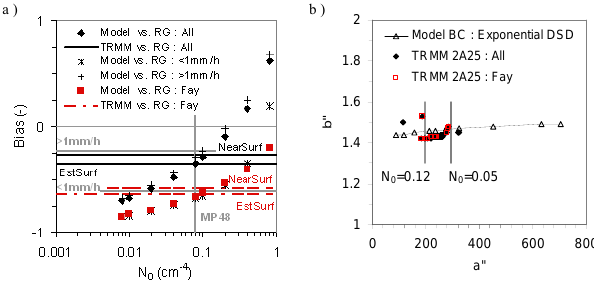
Fig. 9: Model/TRMM/RG comparison: a) Bias between modeled and 10-min rain gauge rain Fig. 9. Model/TRMM/RG comparison: (a) Bias between modeled intensity as a function of N 0 for the period 06/01/08-05/15/09 and for tropical storm Fay on and 10-min rain gauge rain intensity as a function of N 0 for the period 06/01/08–05/15/09 and for tropical storm Fay on 08/26/08. 08/26/08. For the period 06/01/08-05/15/09, TRMM near surface rain-rates are divided into For the period 06/01/08–05/15/09, TRMM near surface rain-rates subcategories (RR>1mm/h and RR<1mm/h). b) Coefficients (a”, b”) of the Z-R relationships are divided into subcategories (RR > 1mm/h and RR < 1mm/h). (b) retrieved from TRMM 2A25 (at point D: see Iguchi et al. 2000 for definition) for the period Coefficients ( a 00 ,b 00 ) of the Z-R relationships retrieved from TRMM 06/01/08-05/15/09 and tropical storm Fay, and for the exponential DSDs used as boundary 2A25 (at point D: see Iguchi et al. 2000 for definition) for the period 06/01/08–05/15/09 and tropical storm Fay, and for the exponential condition in the 1-D microphysical model. DSDs used as boundary condition in the 1-D microphysical